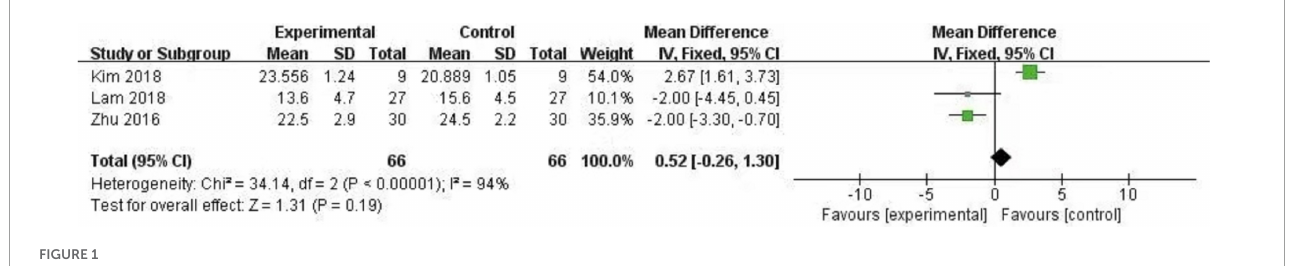
FIGURE1 Forest plot of MMSE